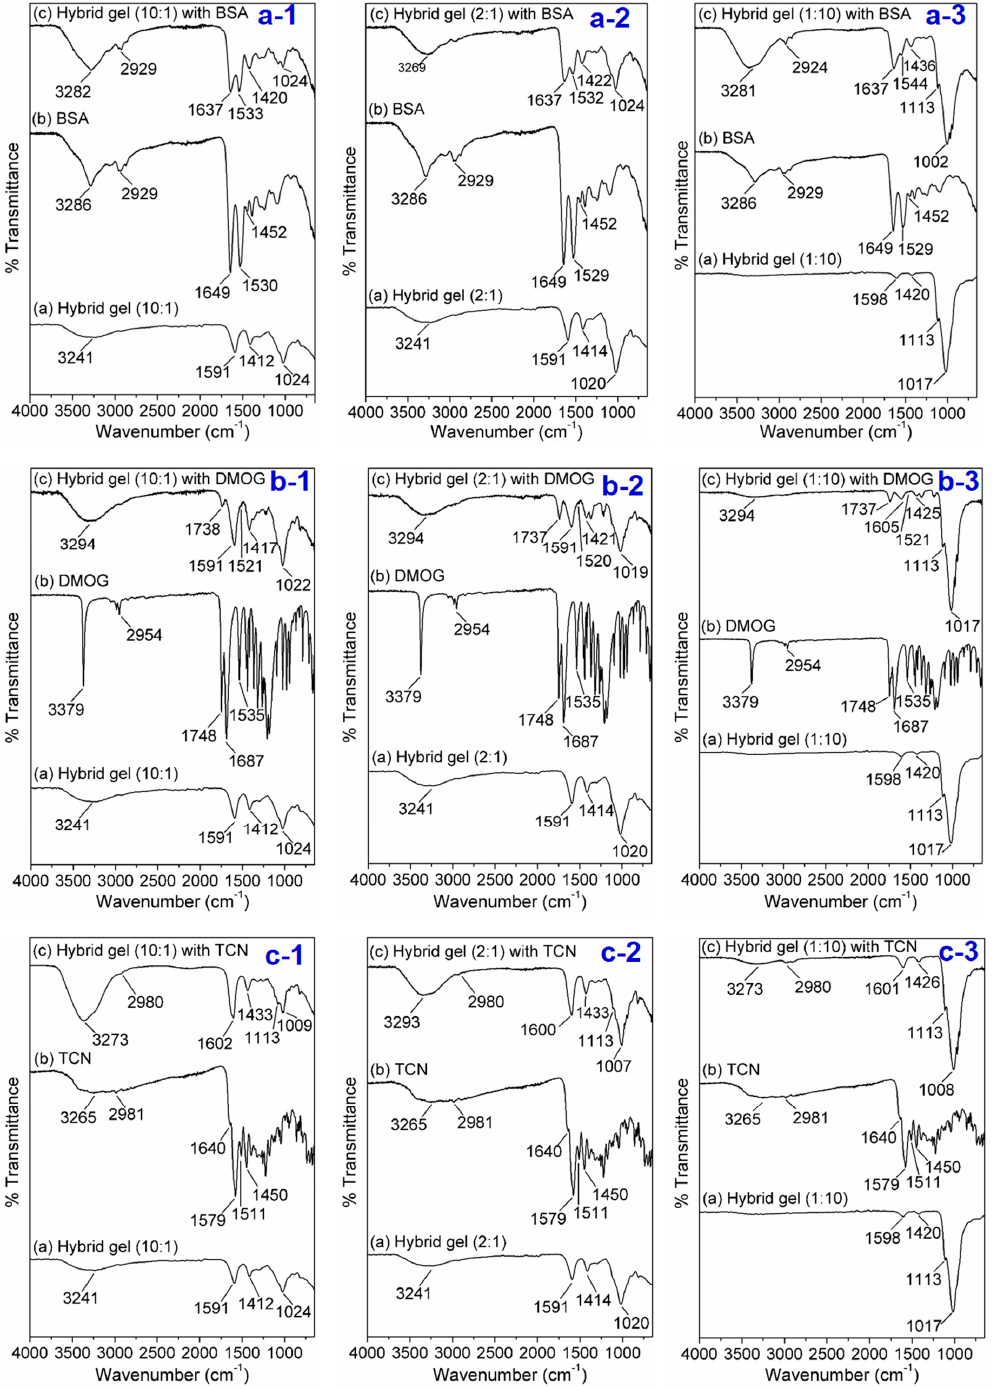
Figure 10. FTIR spectra for the detection of probable interaction between BSA ( a-1–3 ), DMOG ( b-1–3 ), TCN ( c-1–3 ) and Alg- α -TCP (10:1, 2:1 and 1:10) hybrid gels.